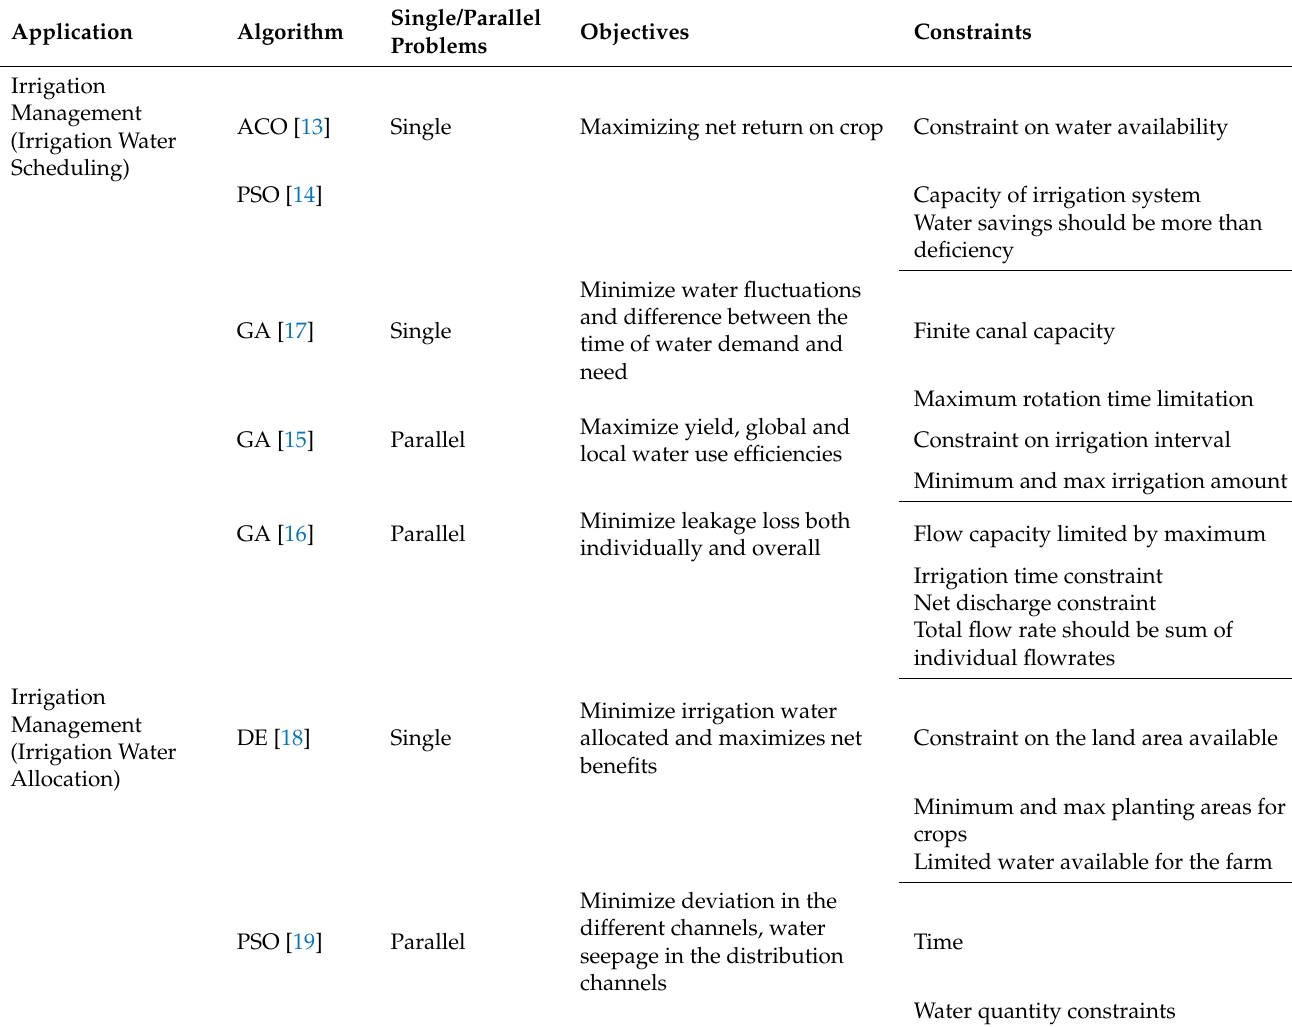
Table 1. Optimization in Smart